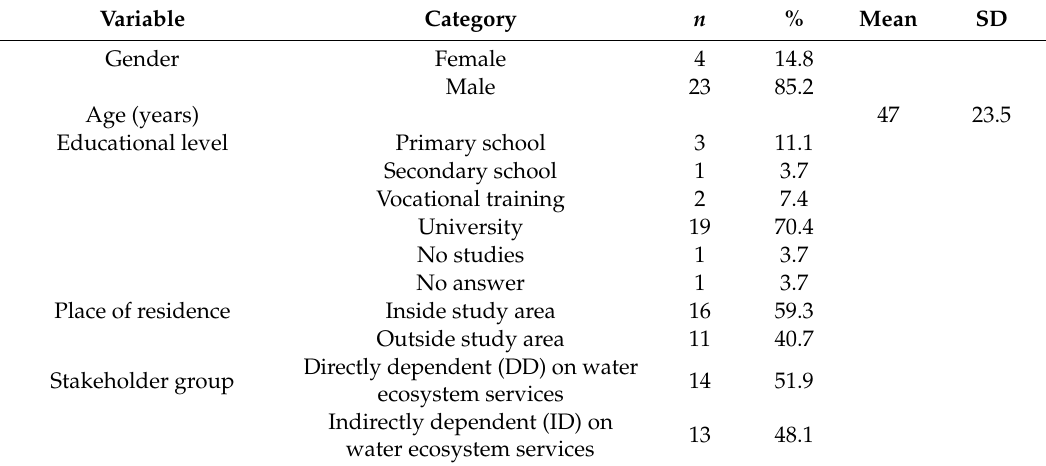
Table 2. Sociodemographic characteristics of stakeholders ( n =